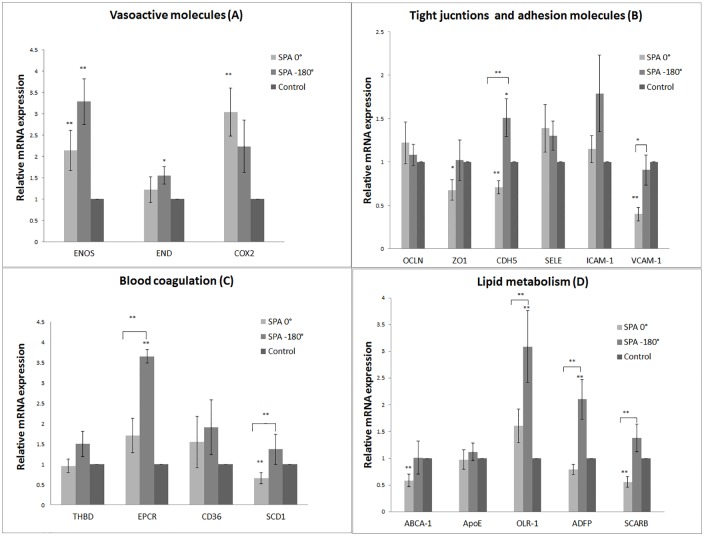
Hemodynamic influences on gene expression.Asynchronous hemodynamic conditions significantly increased the expression of the adhesion molecules CDH5 and VCAM-1 (B). Asynchronous hemodynamic conditions significantly increased EPCR and SCD1 mRNA levels (C). Asynchronous hemodynamic conditions significantly increased the mRNA levels of transcription regulators OLR-1, ADFP, and SCARB1 (D) **p < 0.05, * p<0.1 indicate significant differences for SPA 0° with respect to control or SPA -180° with respect to control. An overbar indicates pairwise significant difference between SPA 0° and SPA -180°. (n = 11)